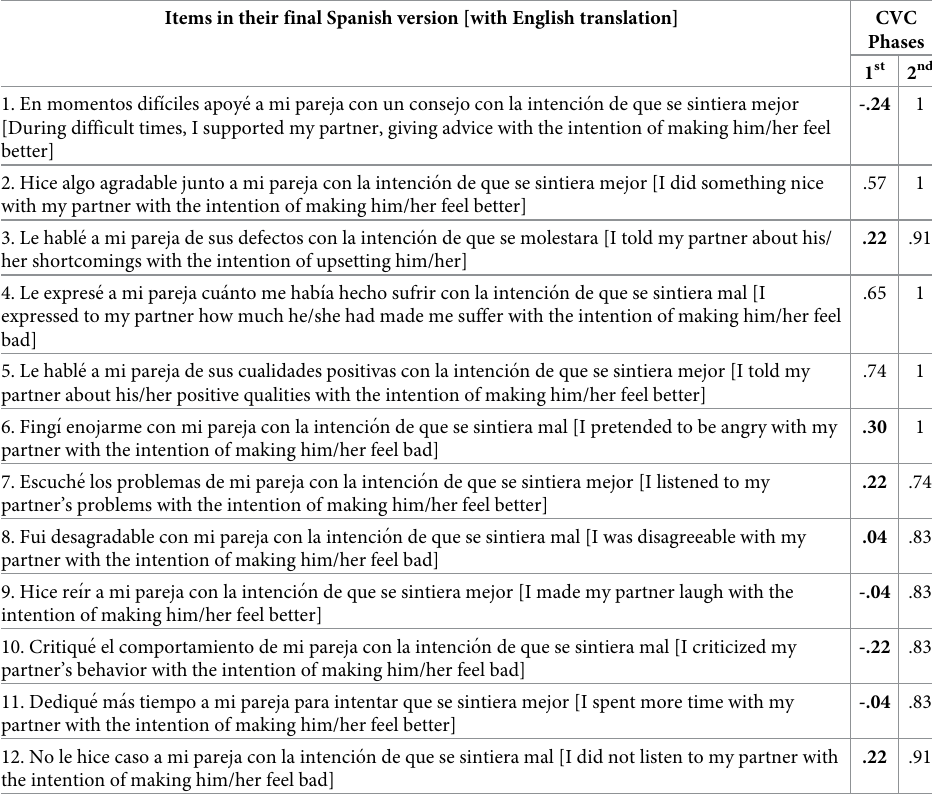
Table 2. Validity results based on test